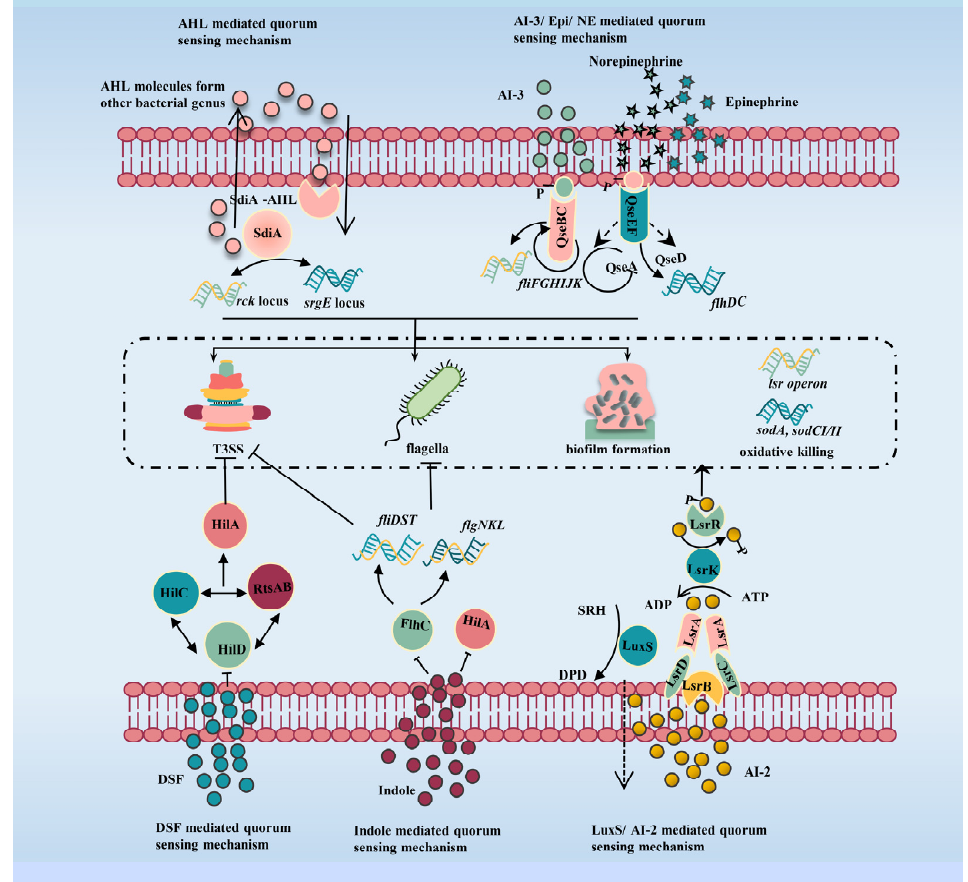
Figure 1. Regulatory mechanisms between QS and virulence in Salmonella . AHL-mediated QS regulated the expression of the srgE and rck locus through the SdiA receptor, which in turn affected the expression of the T3SS genes and bacterial invasion. LuxS/AI-2-mediated QS regulated the expression of flagella-related genes ( fliC , fliD , and flgL ), oxidative stress-response genes ( sodA , sodCI, and sodCII ), and TS33-related genes ( sipA , sipC , and sipD ), which in turn affected bacterial invasion. AI-3/Epi/NE-mediated QS regulated the expression of T3SS genes, which in turn affected bacterial invasion, flagella-related genes, and it can also regulate biofilm formation. DSF-mediated QS inhibited the expression of hliD thus inhibiting the expression of SPI-1. Indole-mediated QS inhibited the expression of hliA thus inhibiting the expression of SPI-1 and also inhibited the expression of flhC thus inhibiting flagella biosynthesis.